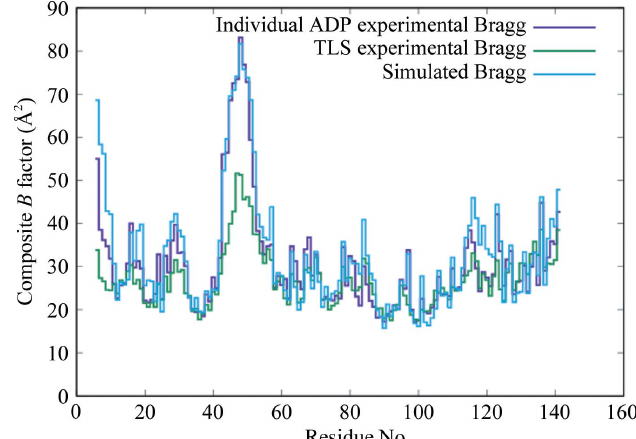
Figure 7 Residue-wise comparison between the B factors from the crystal structure (purple), the MD-simulated average structure (cyan) and a TLS model of the crystal structure (green).